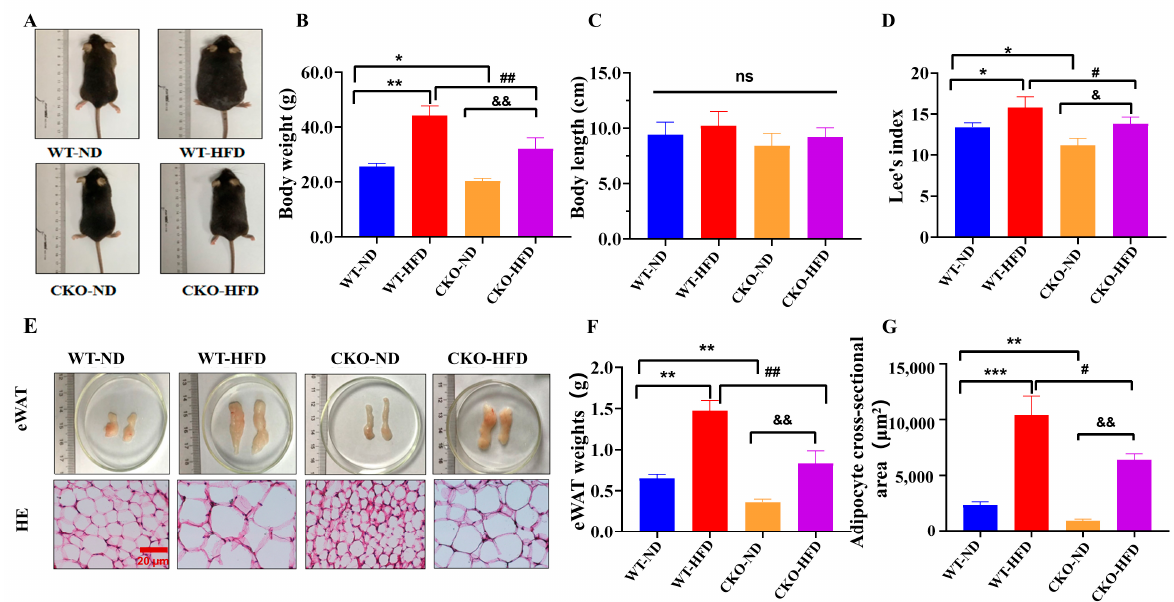
Figure 1. ASP -knockout alleviates mouse obesity induced by HFD. Representative appearance photographs ( A ) of C57BL/6 mice. Body weight ( B ), length ( C ) and Lee’s index ( D ) were measured and calculated. Representative photographs ( E ) and weights ( F ) from eWAT in mice. Representative HE staining images from eWAT ( E ) and adipocyte sizes from eWAT ( G ). Data are presented as mean ± SEM from three independent experiments ( n = 3). Two-way ANOVA was